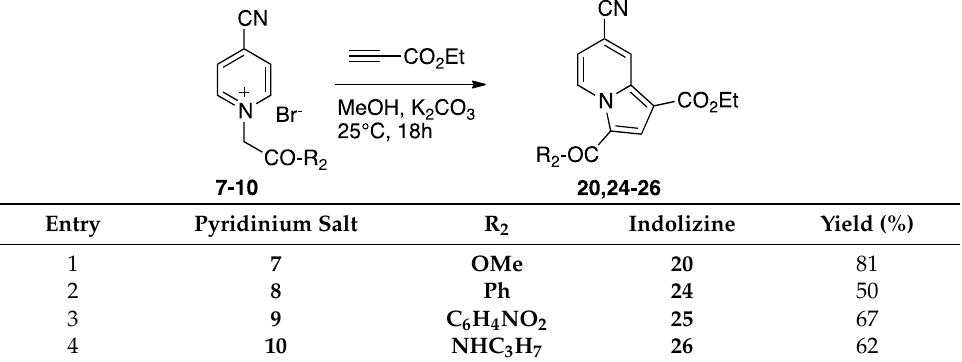
Table 5. Effect of the nature of R 2 group on the yield of 7-cyanoquinazolines.